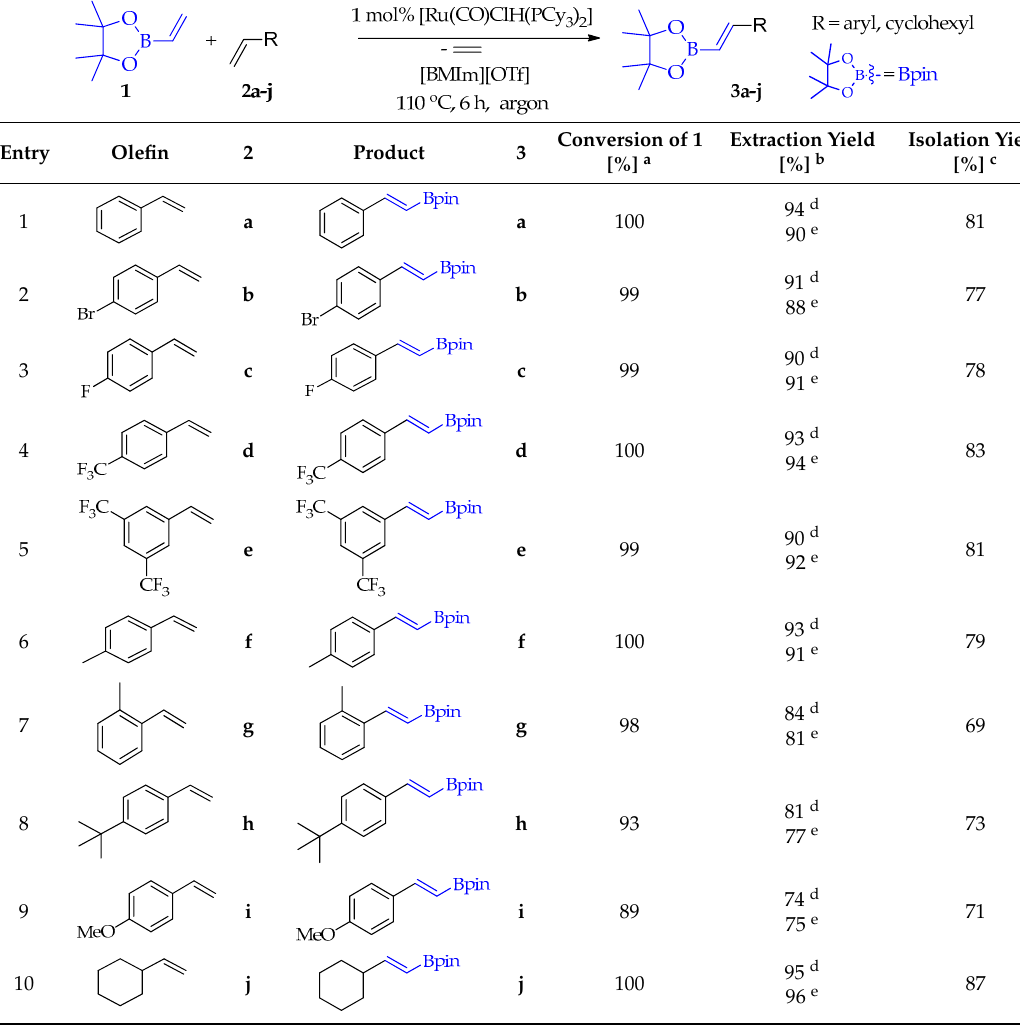
3 ) 2 @[BMIm][OTf] in